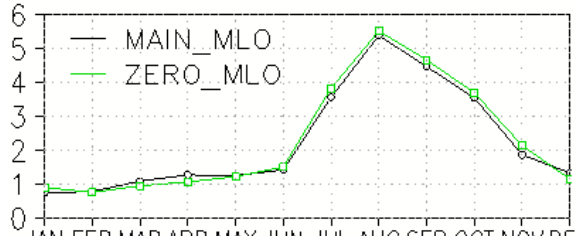
Figure 10. Seven-year monthly mean precipitation (mmd − 1 ) in the longitude–latitude box 65–90 ◦ E, 20–35 ◦ N for simulations above without aerosol–cloud activation (black: MAIN, green: ZERO, yel- low: NOABS) and below with aerosol–cloud activation (black: MAIN_ACT, green: ZERO_ACT, yellow: